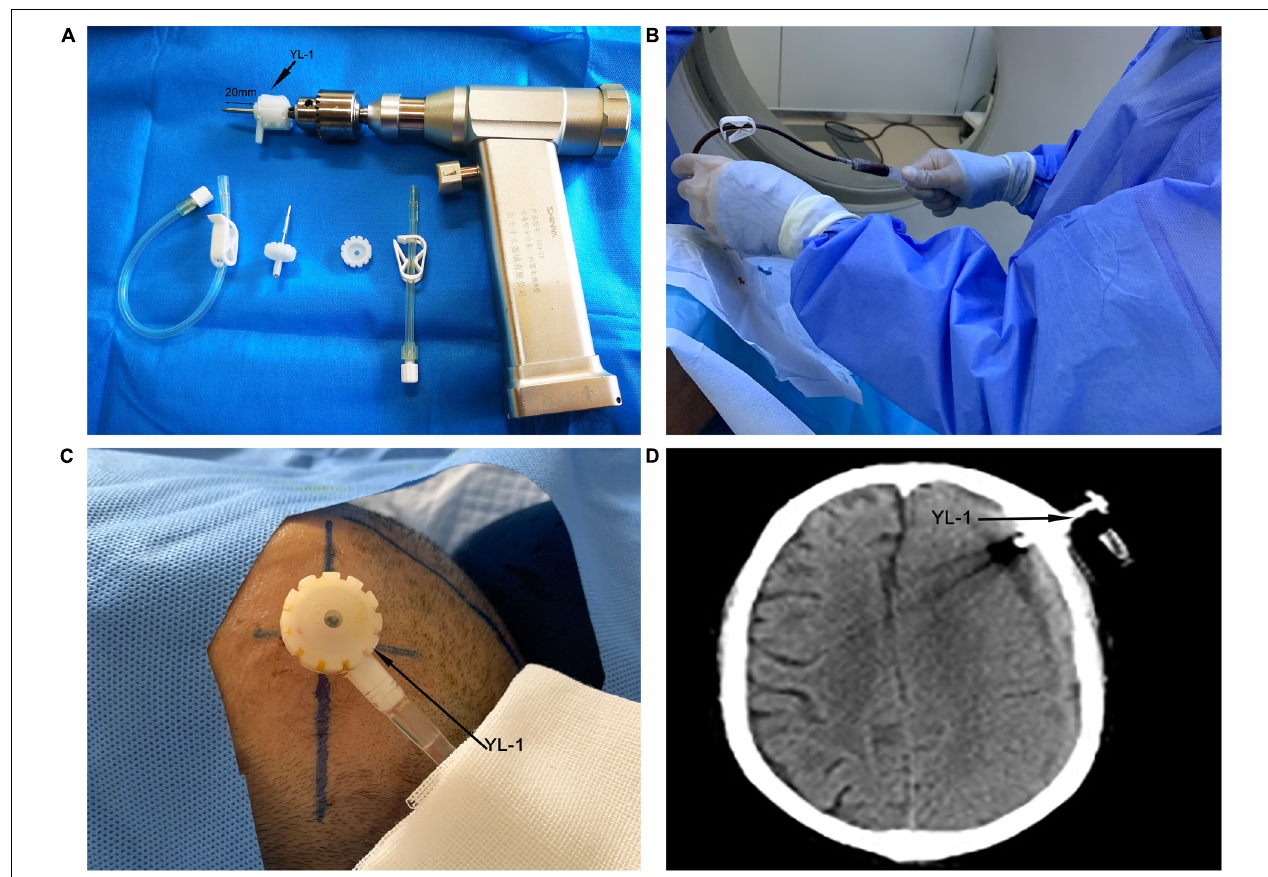
FIGURE 2 | Yl-1 drainage tube (black arrow) before surgery, drill length 20 mm (two black arrows) (A) . YL-1 drainage tube was used to draw and rinse the CSDH during the operation (B) . YL-1 drainage tube (black arrow) continued to drain the hematoma after the operation (C) . YL-1 drainage tube (black arrow) on postoperative CT (D)